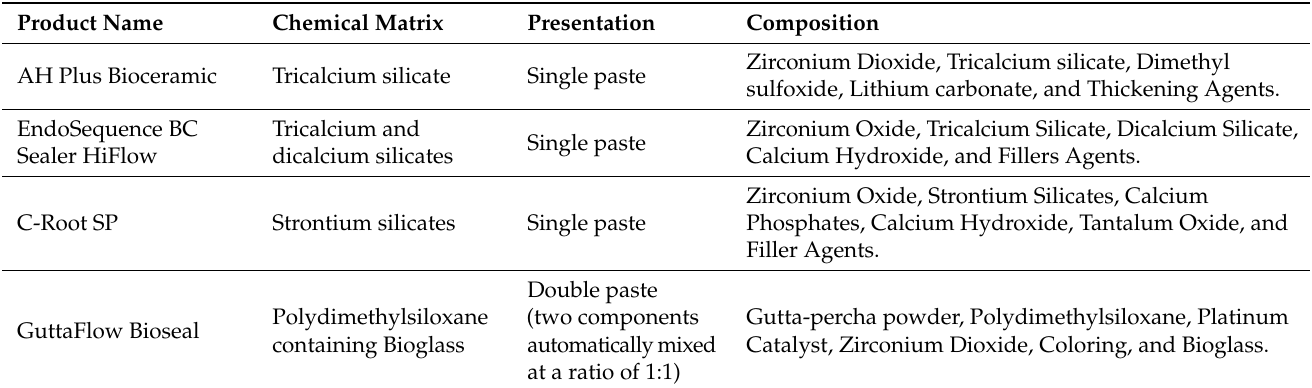
Table 1. Schematic representation of the four endodontic sealers used in the experiment categorized according to the chemical matrix, presentation, and